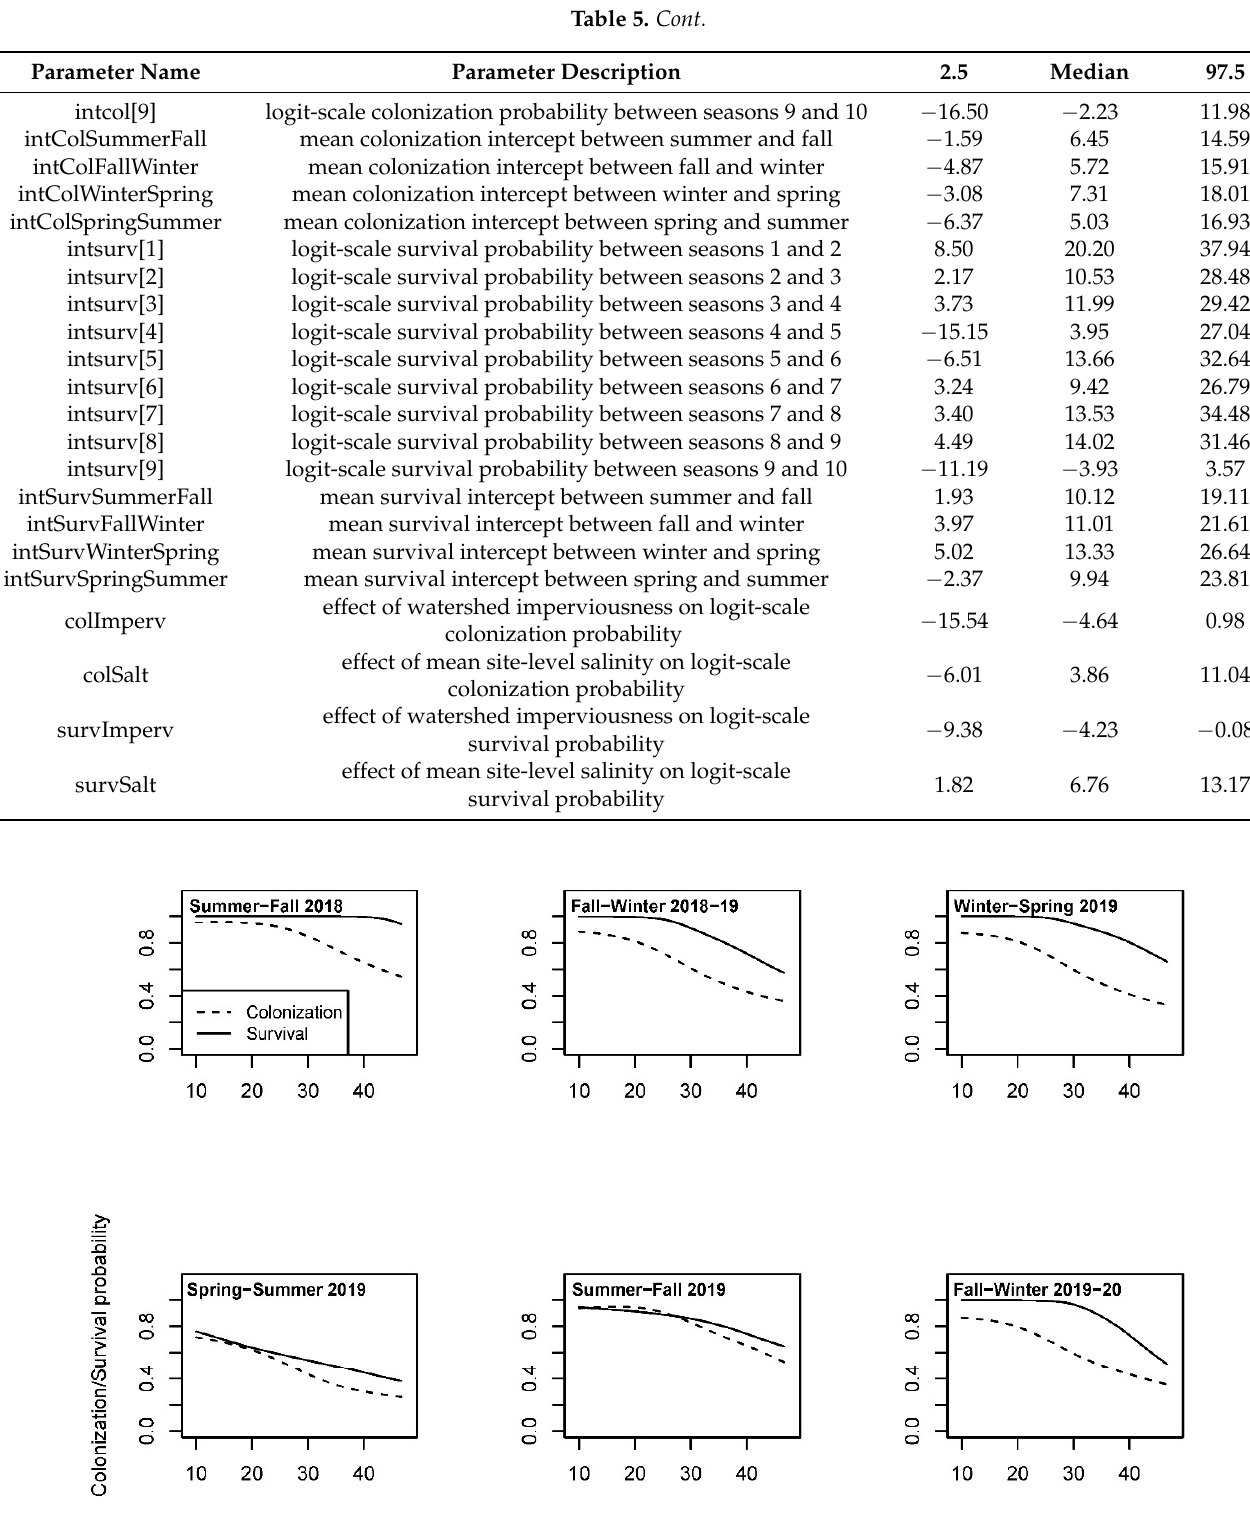
Figure 4. Mean back-transformed predictions of colonization (dashed lines) and survival probability (solid lines) (y-axis) of juvenile blue crabs Callinectes sapidus in North Carolina (USA) tidal creeks as a function of percent watershed impervi- ousness (x-axis). Colonization and survival were predicted for the interval between successive seasons from fitting a dy- namic occupancy model to presence/absence data. Predictions were made across the range of imperviousness values for the watersheds of tidal creeks sampled in this study. The single legend (in the first panel) applies to all graph panels.